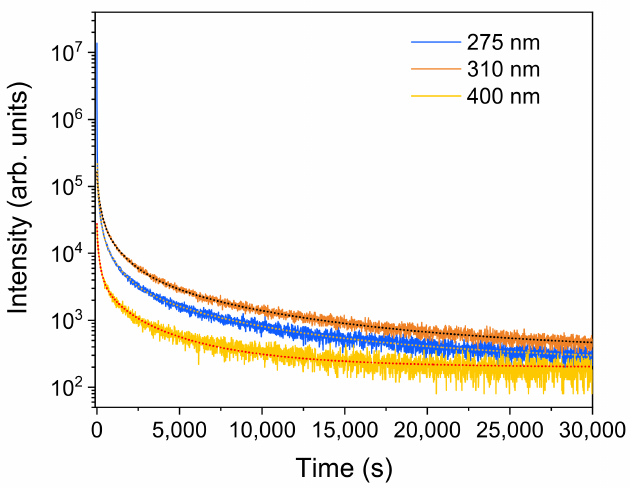
Figure 14. RT wavelength dependence of the red/NIR persistent luminescence decay for the ZGGO:Cr sample and correspondent fittings according to Equation